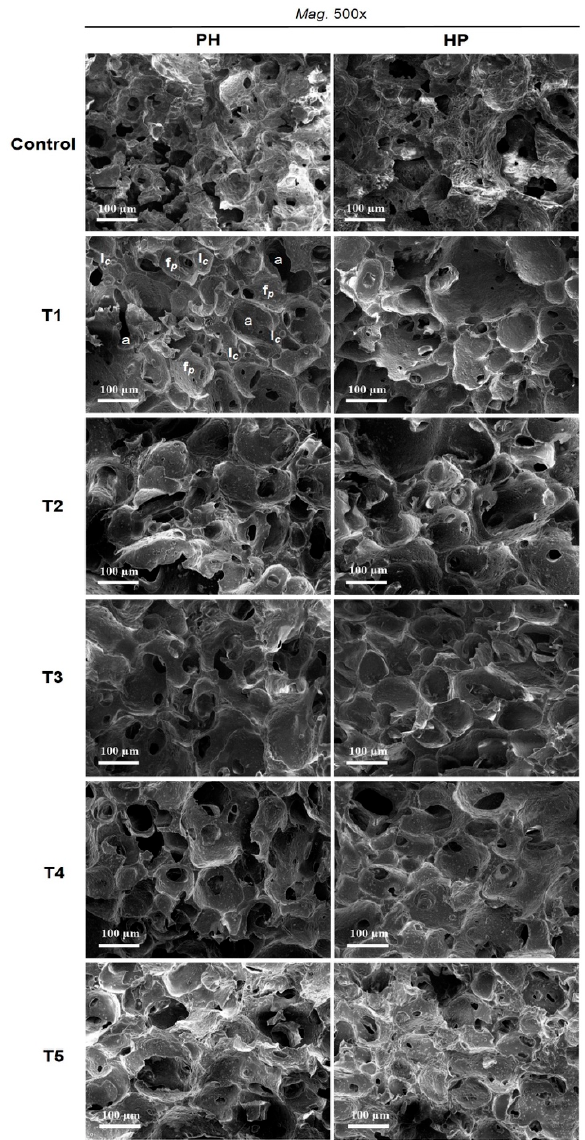
Figure 5. Microstructural properties of ice cream samples including MWPs at a magnification of 500×; a denotes integrated air bubbles, I c denotes ice crystals, and f p denotes fat globules and inte ‐ grated particles of MWPs on the surface of ice cream. See Table 1 for the definitions of treatment abbreviations.